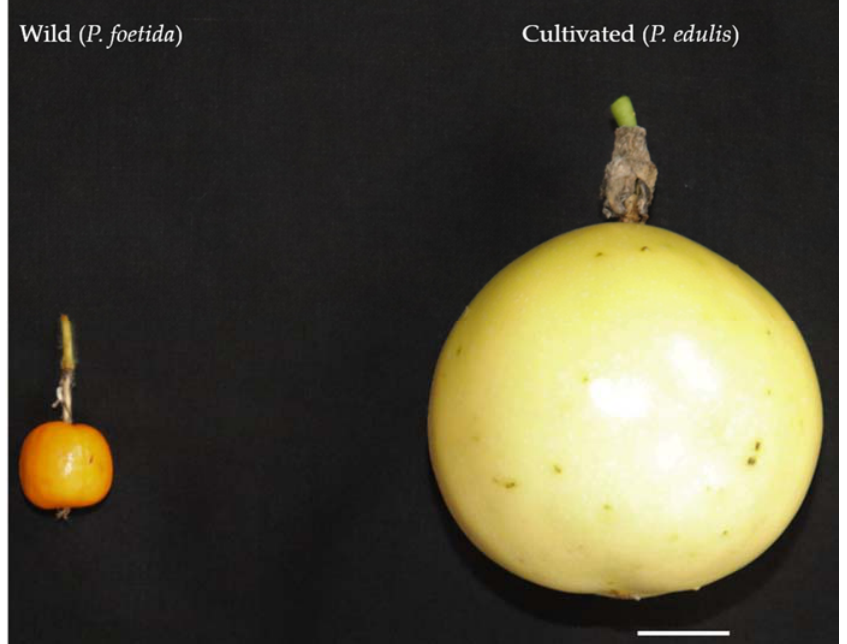
Figure 2. Differences in fruit morphology between P. foetida (wild) and P. edulis (cultivated; scale bar = 1 cm). The size and colour differences are notable between the wild and cultivated species of Passiflora .